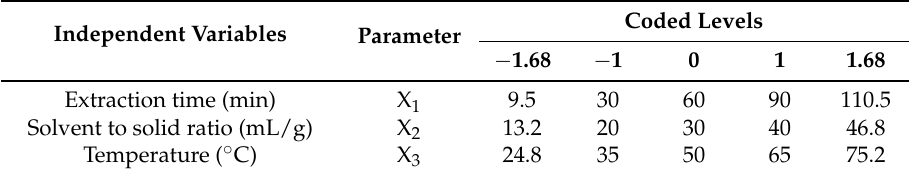
Table 6. Range of extraction condition variables at different levels for the central composite